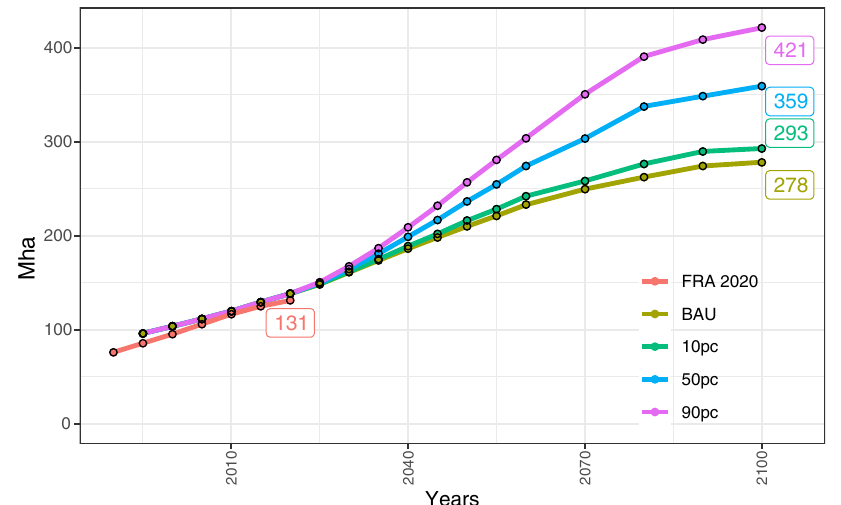
Fig.1 |Evolutionoftheglobalforestplantationareabetween1995and2100in anSSP2world. Business-as-usual(BAU)scenarioiscomparedto,the10%,50%,and 90% (10pc, 50pc, 90pc) engineered wood demand scenarios where 10%, 50%, or 90% of the new urban population will live in wooden buildings,